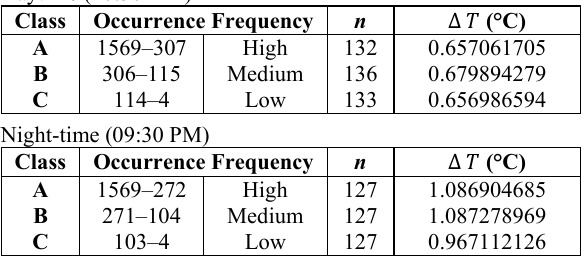
Table 3. Ordinal classification of the ventilation corridors